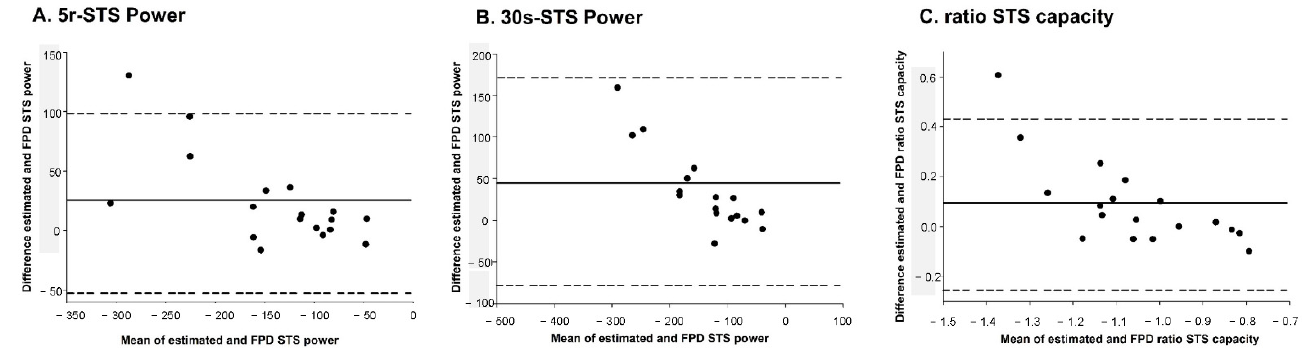
Figure 4. Bland–Altman plots showing differences between estimated and FPD 5r-STS power ( A ) and between estimated and FPD 30s-STS power ( B ) and between estimated and FPD STS capacity ratio ( C ). The solid line is the mean difference; the upper and lower dotted lines represent the upper and lower 95% limits of agreement,